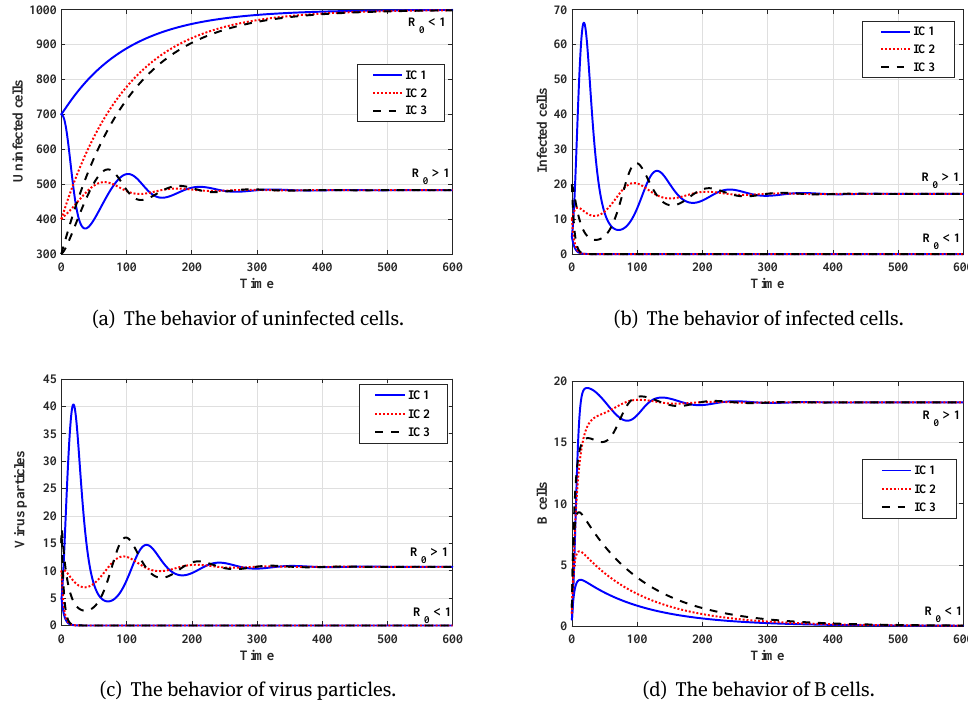
Figure 1: Solution trajectories of system (31)-(34) in case α 1 = α 2 = 0 .